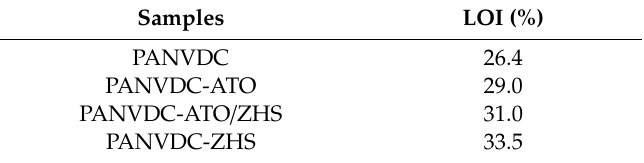
Table 5. Limiting oxygen index (LOI) values of the PANVDC films with the flame